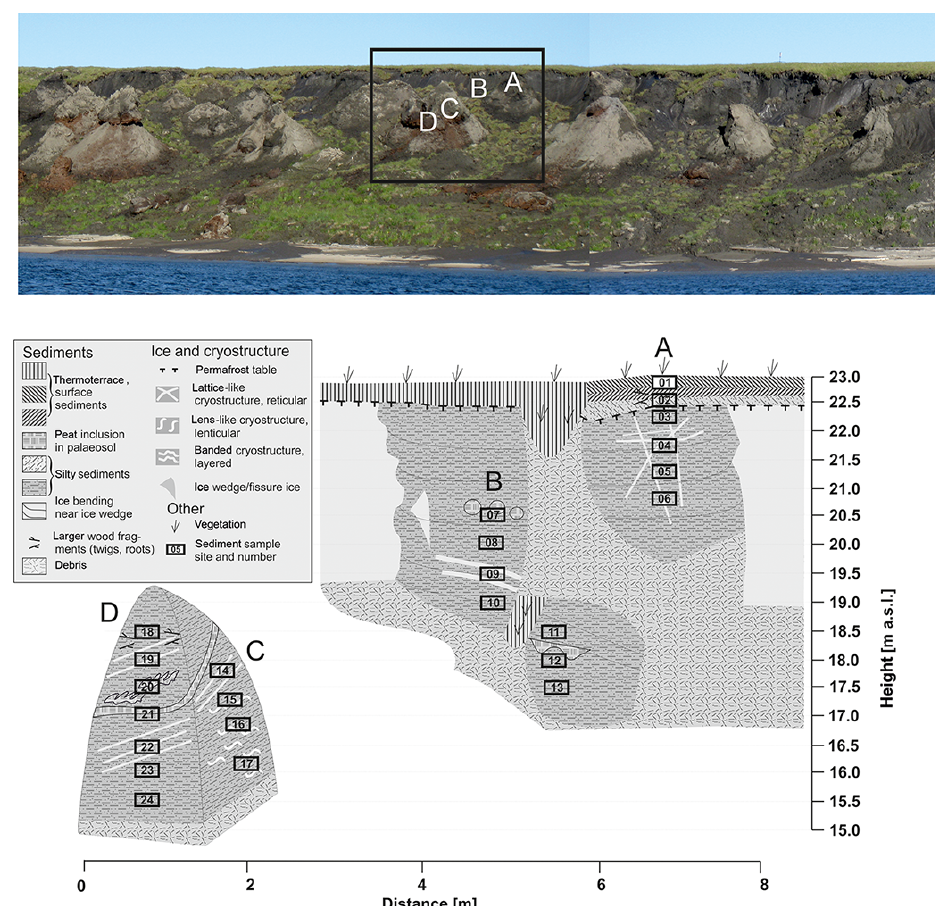
Figure 3. Overview photo and scheme of the Buo-02 Yedoma IC exposure with sample positions and main cryolithological features (modified from Strauss and Schirrmeister,